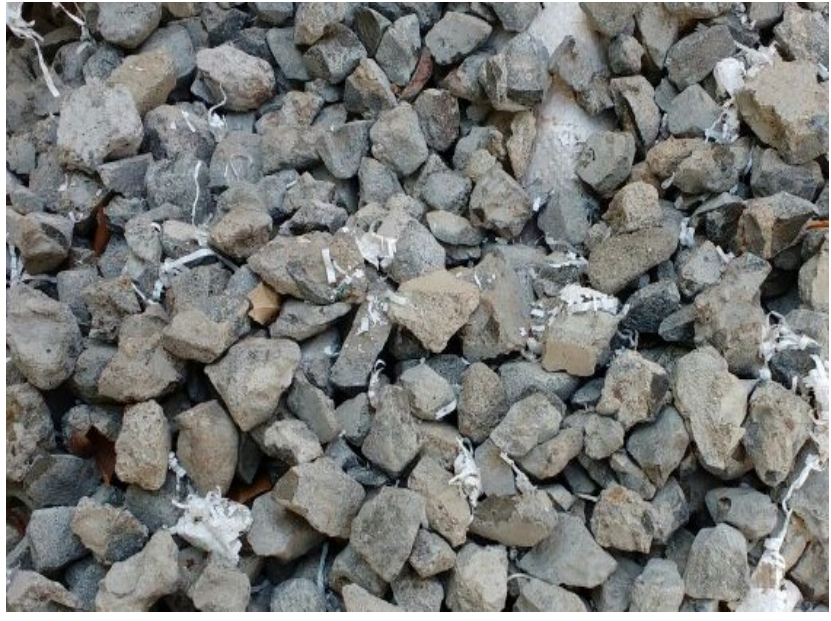
Fig. 1. RA before abrasion